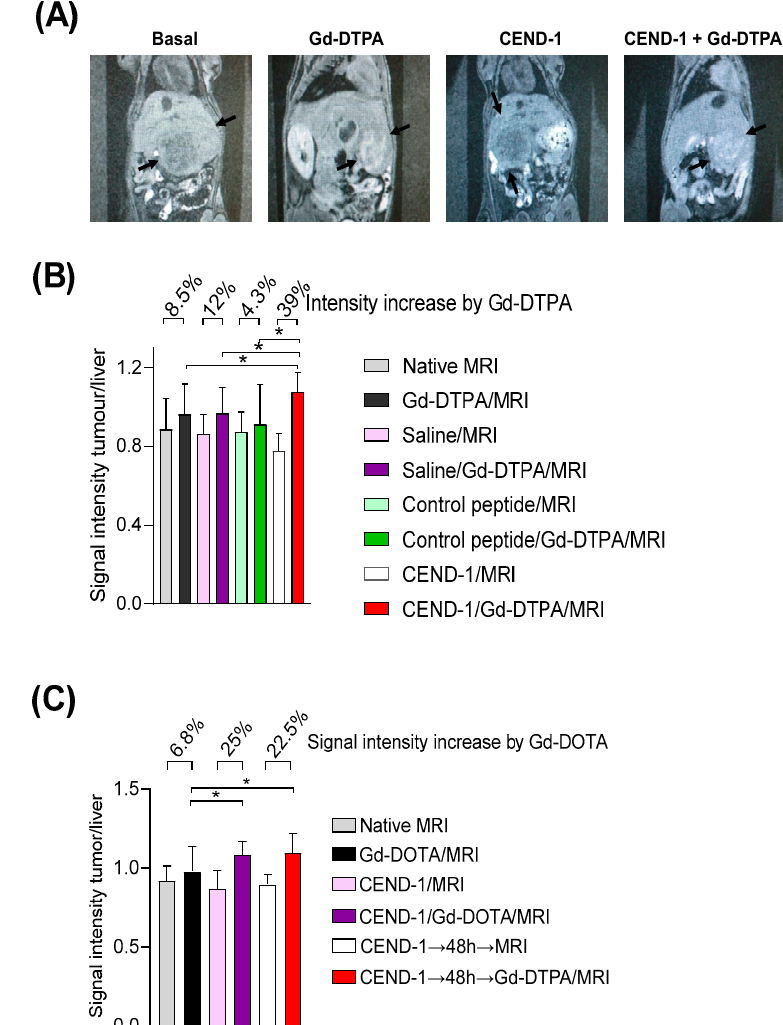
Figure 5. Injection of CEND-1 into TGF α /c- myc mice with HCC caused an increased accumulation of contrast agent in the tumour, when the contrast agent was administered 48 h later. ( A ) CEND-1 increased the MRI signal in the tumour of TGF α / c-myc HCC mice. Arrays indicate the tumours. ( B ) Ratio of tumour/liver signal intensity following the treatments. Asterisks indicate a significant difference * p < 0.05 compared to the three previous measurements. N = 8 per group. ( C ). CEND-1 elicited a prolonged increase in tumour penetrability in TGF α /c-myc HCC mice. TGF α /c-myc mice with suitable tumours according to Gd-EOB-DTPA-enhanced MRI received MRI before and after the injection of Gd-DTPA. After 2 days, MRI was performed before and after the injection of CEND-1, followed by the injection of Gd-DTPA and another MRI. Another 2 days later, the mice received additional Gd-DTPA-enhanced MRI. Bars represent mean ± SD; asterisks indicate significant differences (One way ANOVA with Tukey’s multiple comparisons test). * p < 0.05. n =